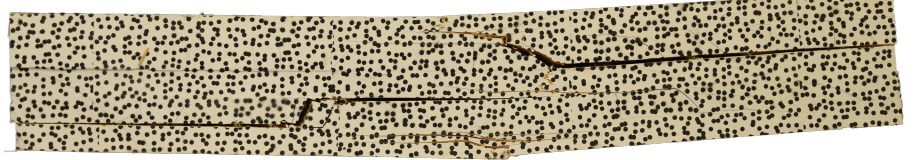
Figure 24. CLT5-10 Post-dynamic